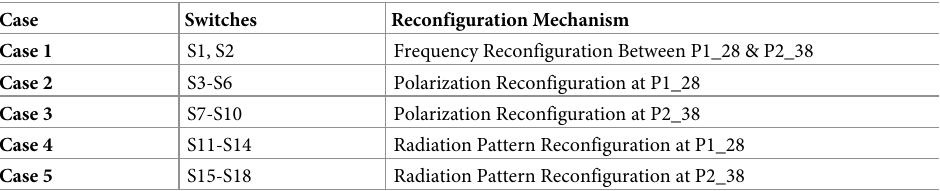
Table 5. Cases to be observed for analysis of hybrid reconfiguration